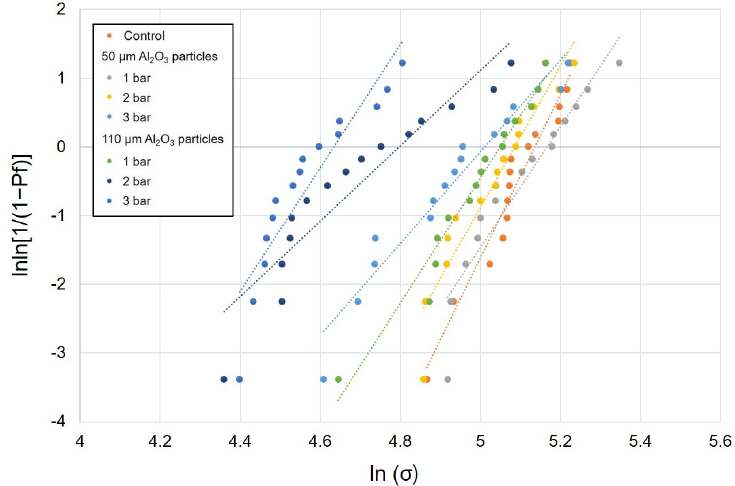
Figure 4. Weibull plot of disperse-filled composites specimens subjected to air abrasion with alumina particles of different sizes at different pressures.